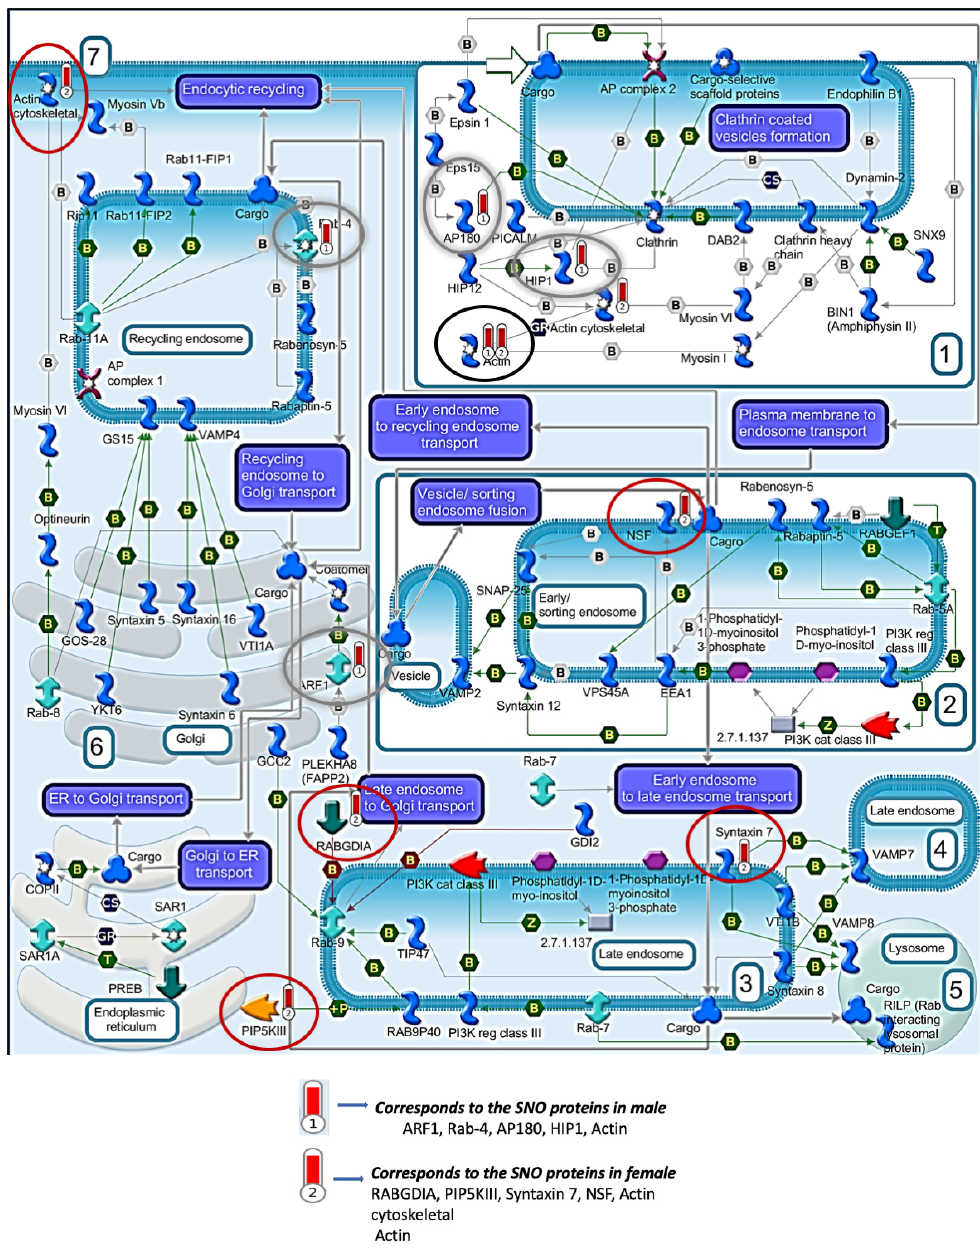
Figure 3. “Clathrin-coated vesicle cycle” pathway was enriched in both sexes. Red circles are SNO proteins in female. Gray circles are SNO proteins in male. Black circles are SNO proteins in both female and male groups.